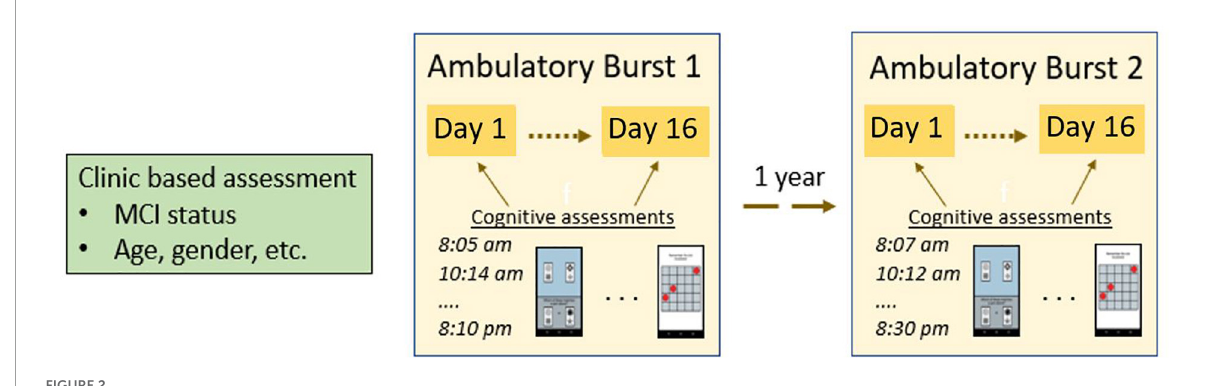
FIGURE2 Illustration of a measurement burst design with two bursts.